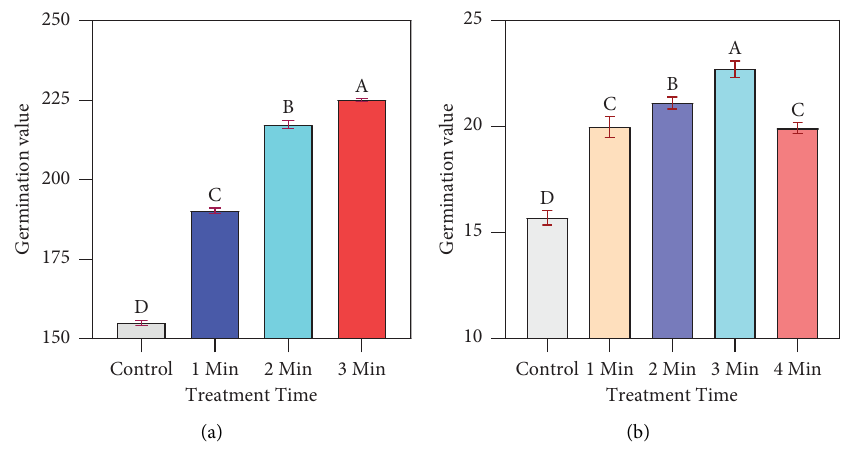
Figure 15: Efect of plasma on germination value of (a) radish and (b)